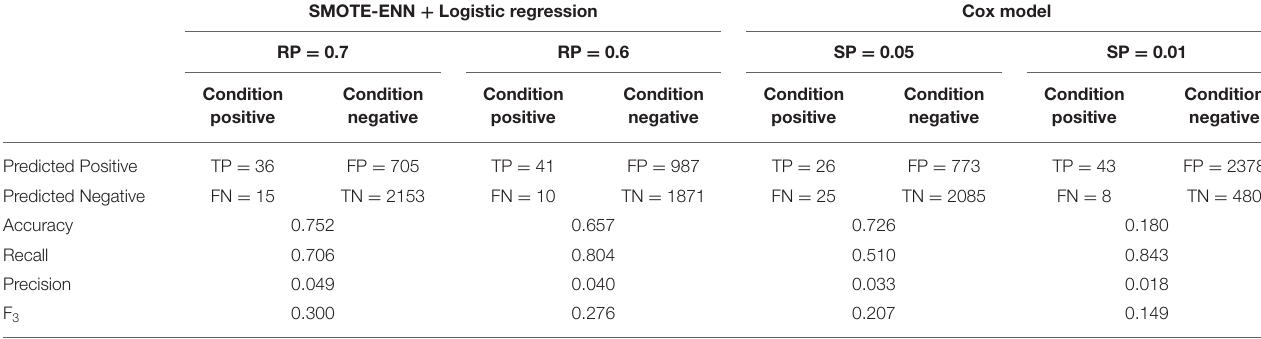
TABLE 4 | Prediction performance of the Cox proportional hazards model with different